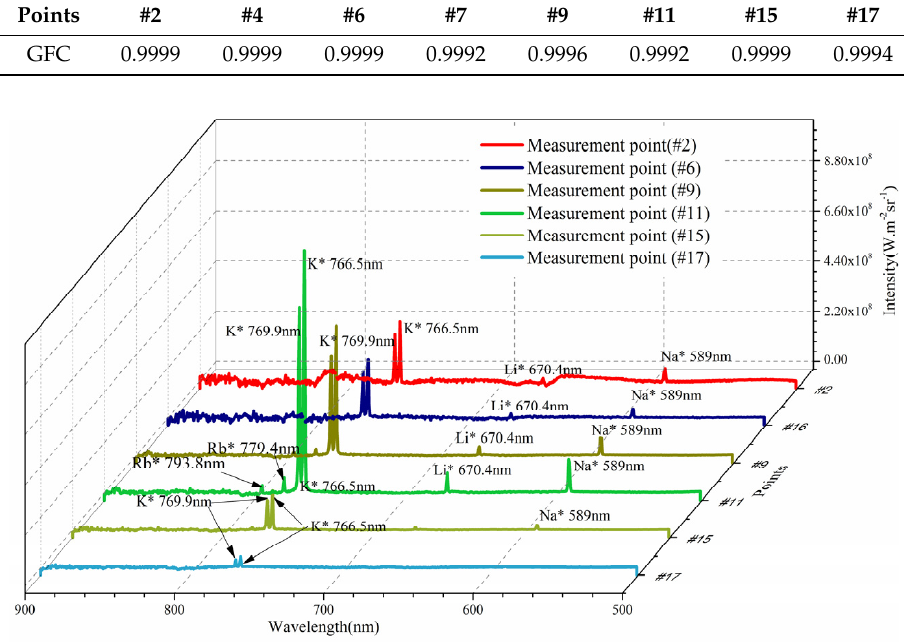
Figure 10. Discontinuous spectra separated from the flame radiation spectrum.